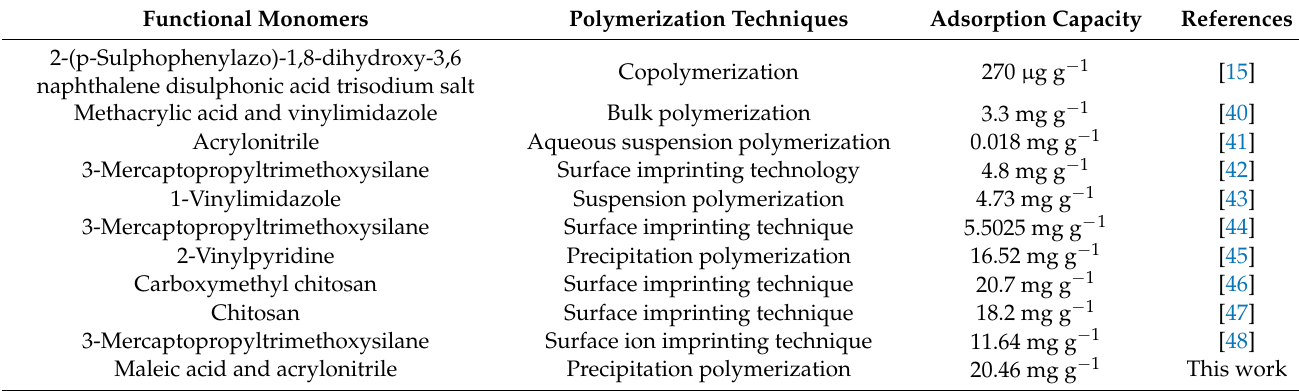
Table 5. Comparative